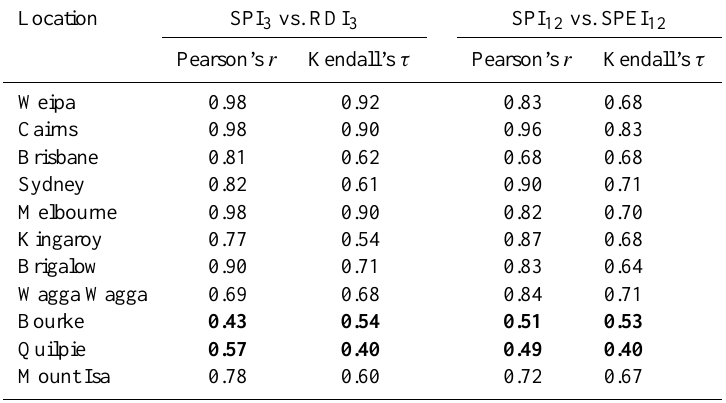
Table E1. Coefficient values of Pearson’s r and Kendall’s τ for SPI 3 vs. RDI 3 , and SPI 12 vs. SPEI 12 . Correlations were lowest for arid Bourke and Quilpie (bold